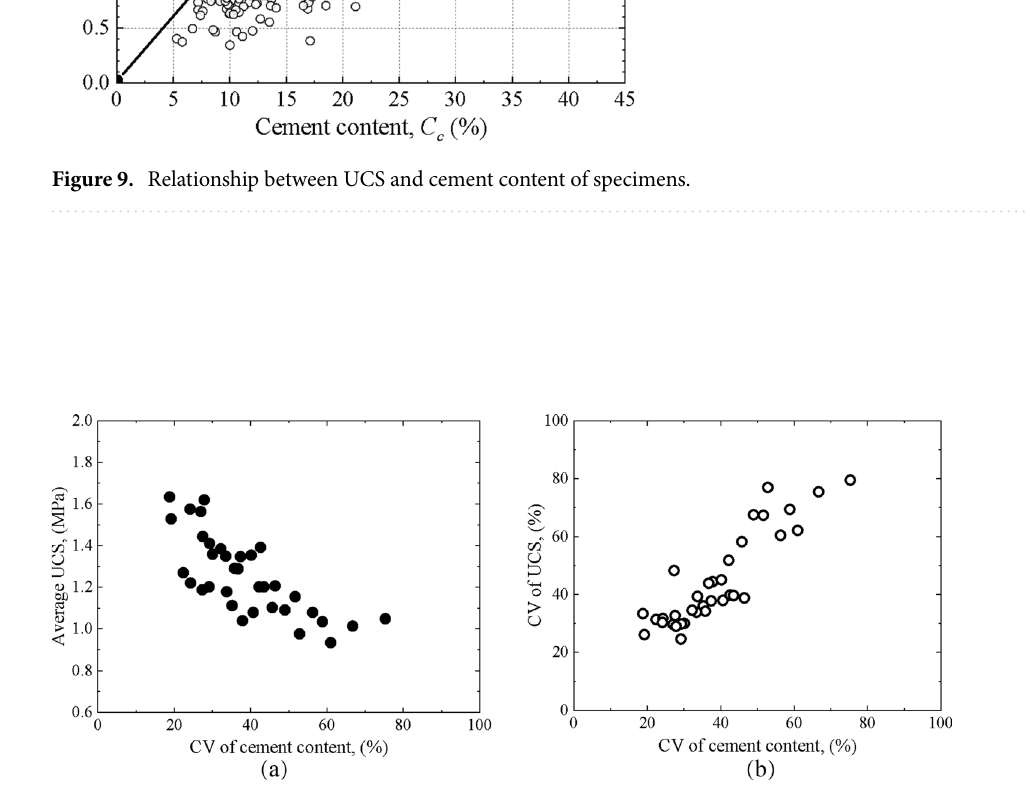
Figure 10. Relationship between UCS and CV of cement content of single columns ( a ) Average UCS, ( b ) CV of